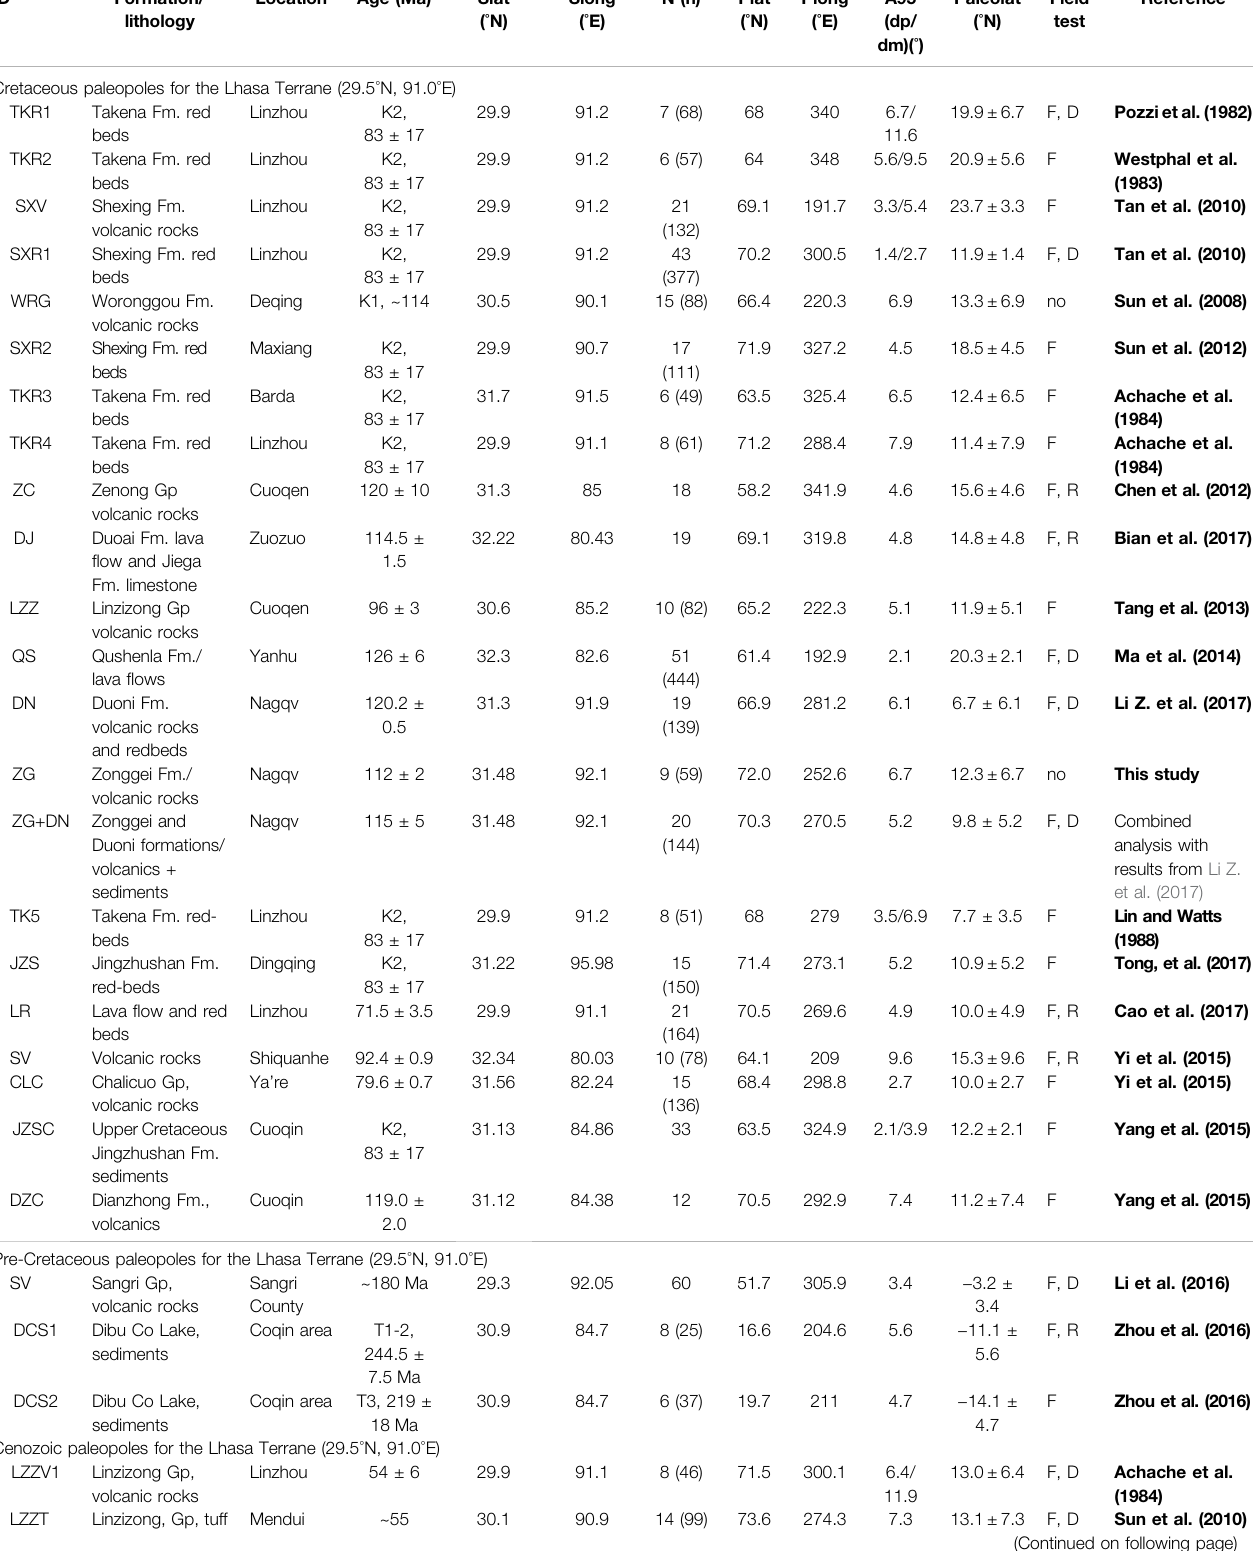
TABLE 2 | Summary of Cretaceous and Early Cenozoic paleomagnetic poles from the Lhasa and Tethyan-Himalayan (two are from interior of Indian craton) terranes. ID Formation/ lithology